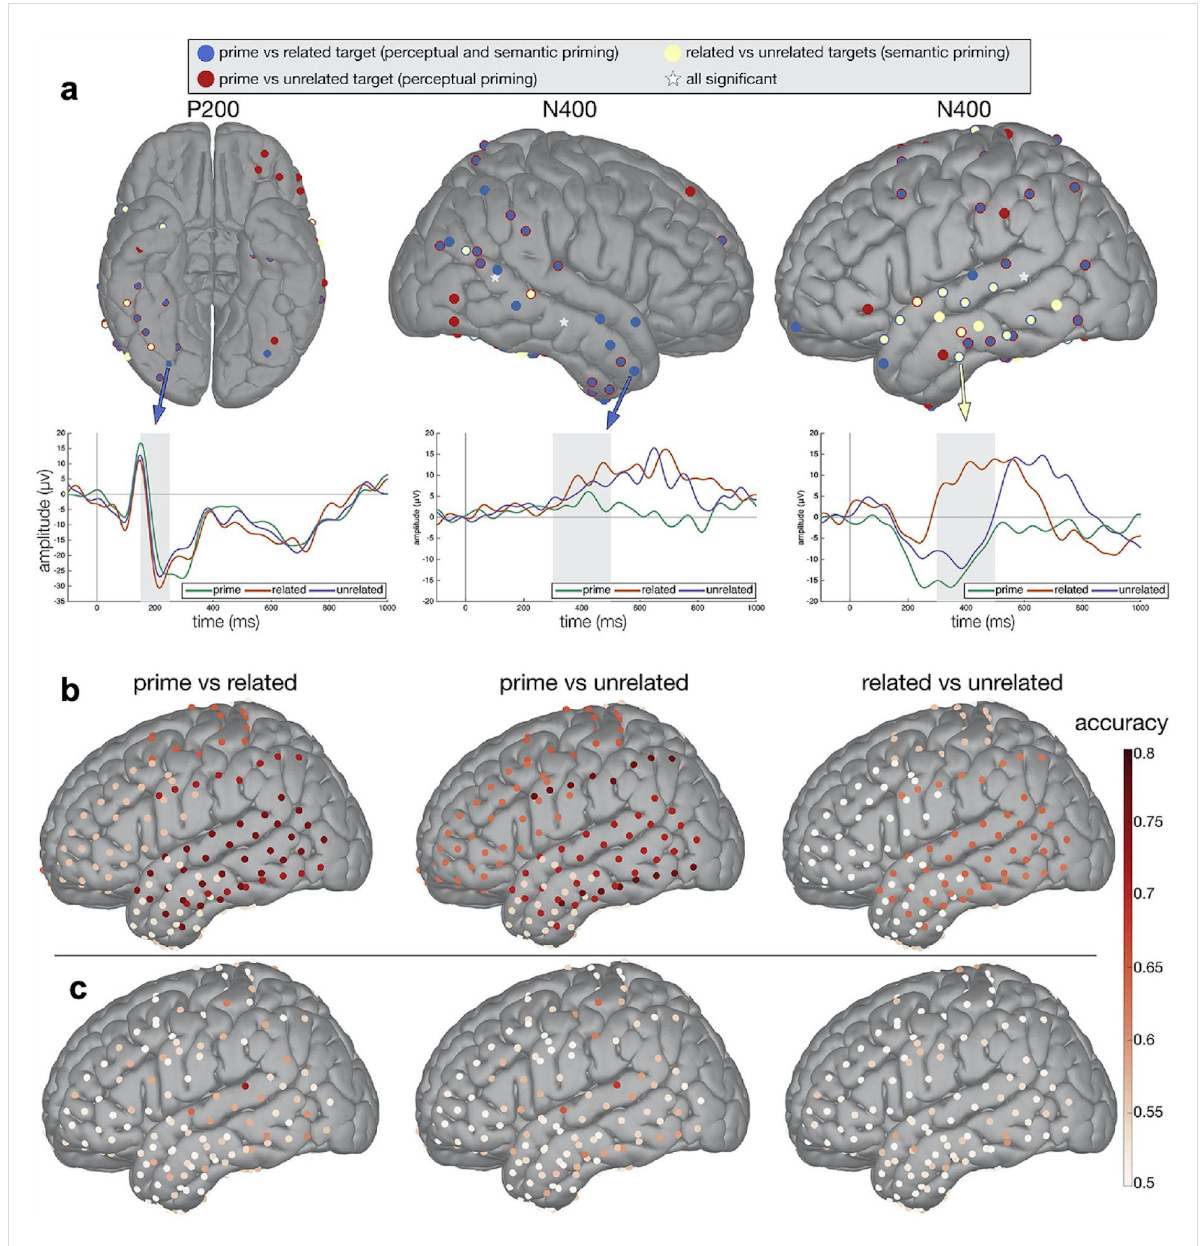
Figure 4: ERP analysis suggests semantic priming centralises in the left temporal cortex, whereas perceptual priming is widespread. (a) ERP analy- sis suggests the spatial and temporal distribution of semantic and perceptual priming effects. (b) Results of multichannel classification analysis. (c) Results for single channel classification analysis. Figure 4 was reprinted from [64], NeuroImage, vol. 203, by E. Khachatryan; B. Wittevrongel; M. F. Hnazaee; E. Carette; I. Dauwe; A. Meurs; P. Boon; D. van Roost; M. M. Van Hulle, “Semantic and perceptual priming activate partially overlapping brain networks as revealed by direct cortical recordings in humans”, article no. 116204, Copyright (2019), with permission from Elsevier.